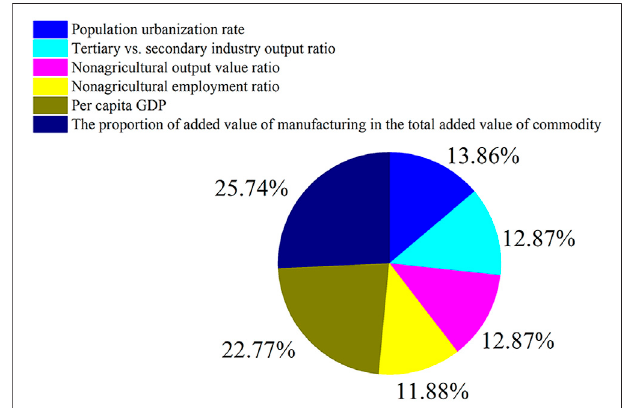
FIGURE 2 | Contribution of different indicators to